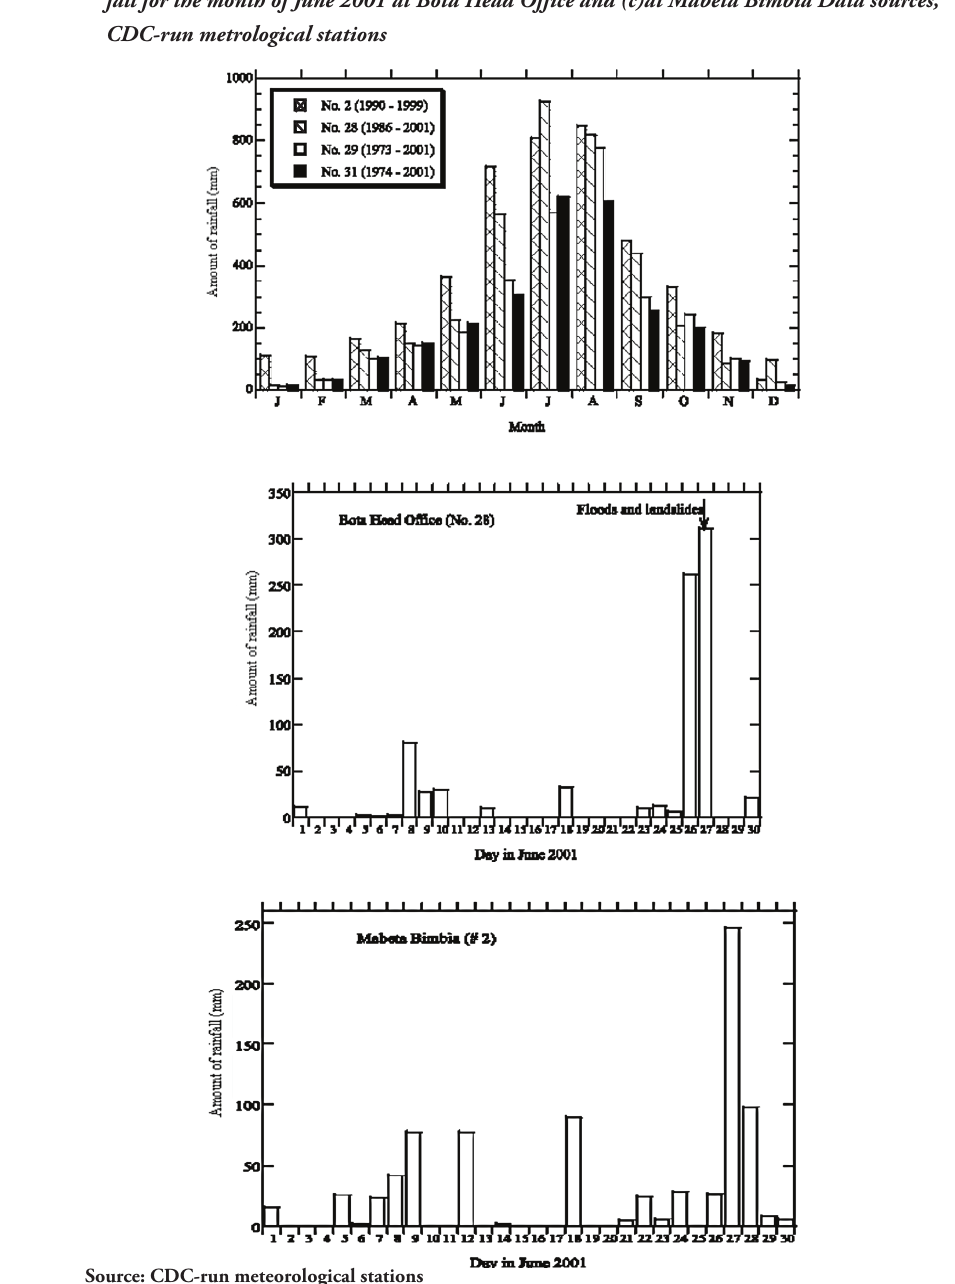
Fig.6 (a), Mean yearly rainfall for 4 stations around Limbe from 1971 to 2001 (b) daily rain- fall for the month of June 2001 at Bota Head Office and (c)at Mabeta Bimbia Data sources, CDC-run metrological